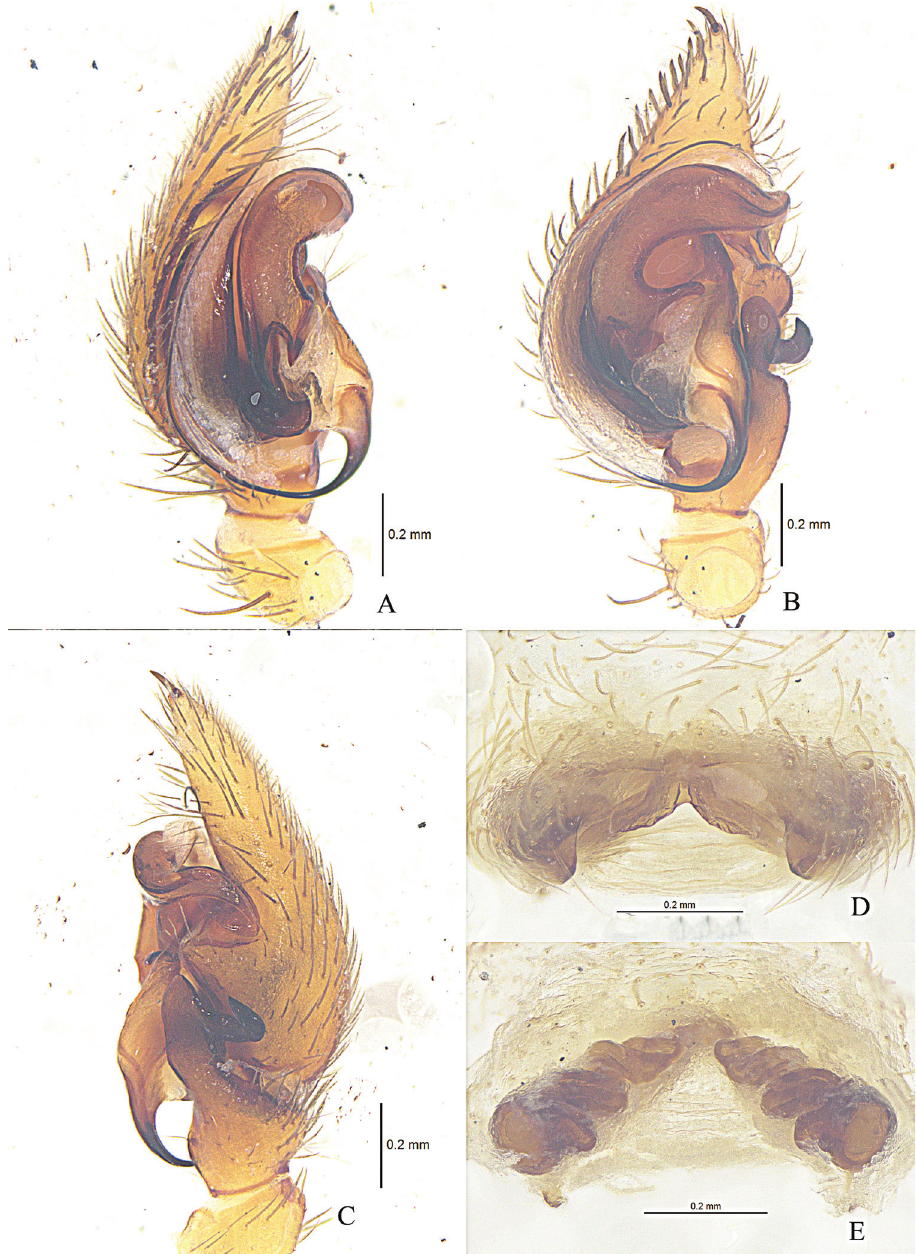
Figure 10. Zodarion chaoyangense Zhu & Zhu, 1983, male holotype left palp ( A–C ) and female paratype ( D, E ) A Prolateral view B Ventral view C Retrolateral view D Epigynum, ventral view E Vulva, dorsal